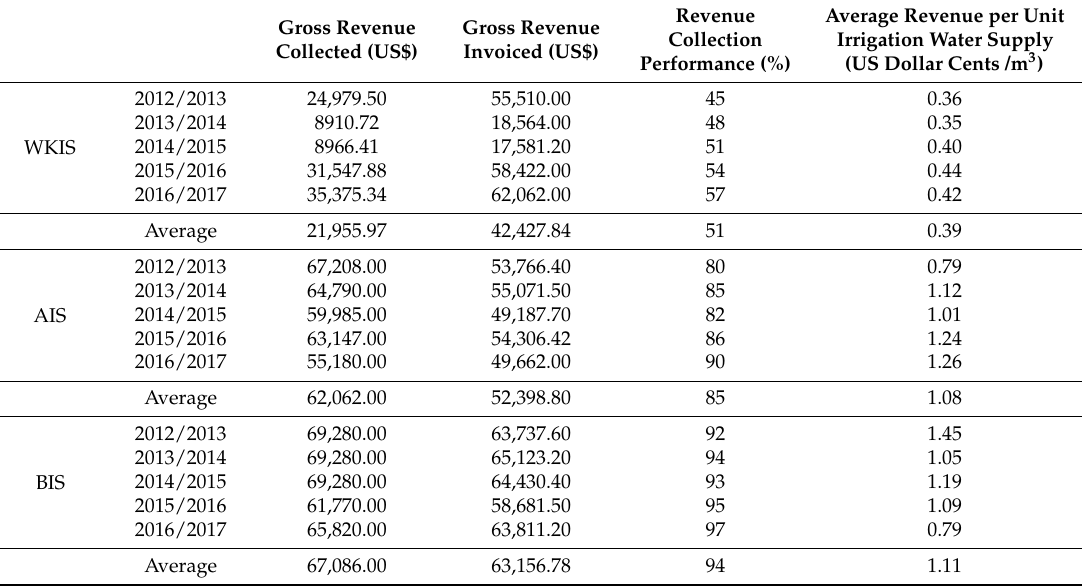
Table 7. Financial performance